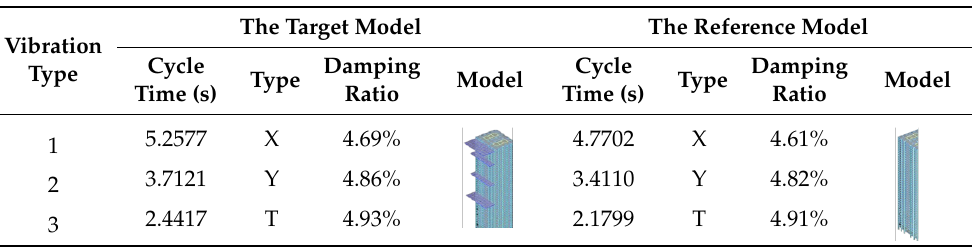
Table 2. Self-oscillation period and vibration direction of building structures.